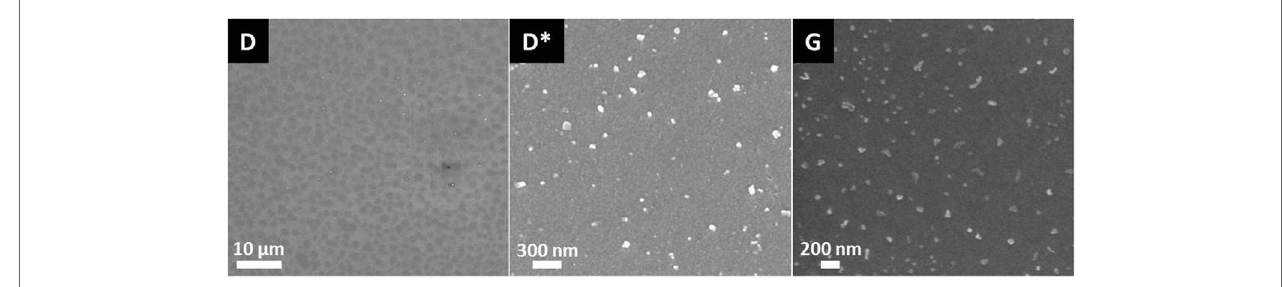
FigUre 2 | Microstructures of glass D after nucleation for 10 h at 500°c and of glass g after nucleation at 500°c for 30 min